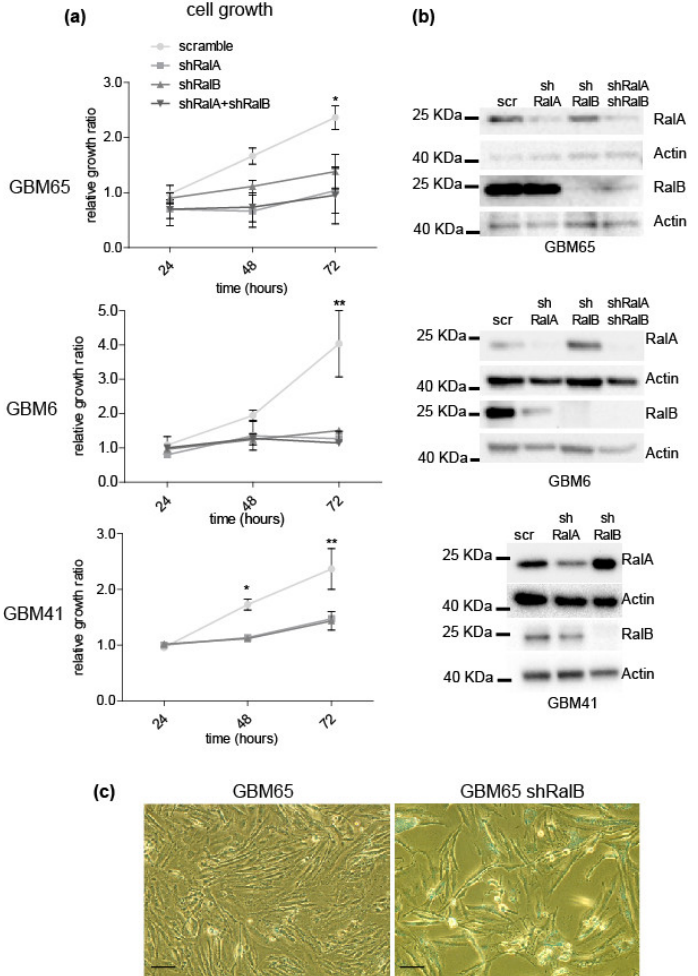
Figure 2. Knockdown of Ral GTPases promotes a reduction of cell growth without affecting cell viability. Primary GBM cells were infected with lentivirus, driving interference RNA against RalA (shRalA) or RalB (shRalB) or both. Scramble shRNA was used as a control. Three days after infection, cells were seeded and counted every 24 h for 3 days. ( a ) Graphics and bar diagrams representing growth of knockdown GBM cells. Data is represented as mean ± SEM ( n = 3; three independent experiments). Scramble group was compared with the other three conditions by ANOVA and Tukey-HSD post-test (* p < 0.05; ** p < 0.01). ( b ) Western blot to determine the levels of RalA and B in primary GBM cells after knockdown. β-actin was used as a loading control. ( c ) Representative phase-contrast images of GBM65 cells were taken after 4 days of infection (50 μm bar).